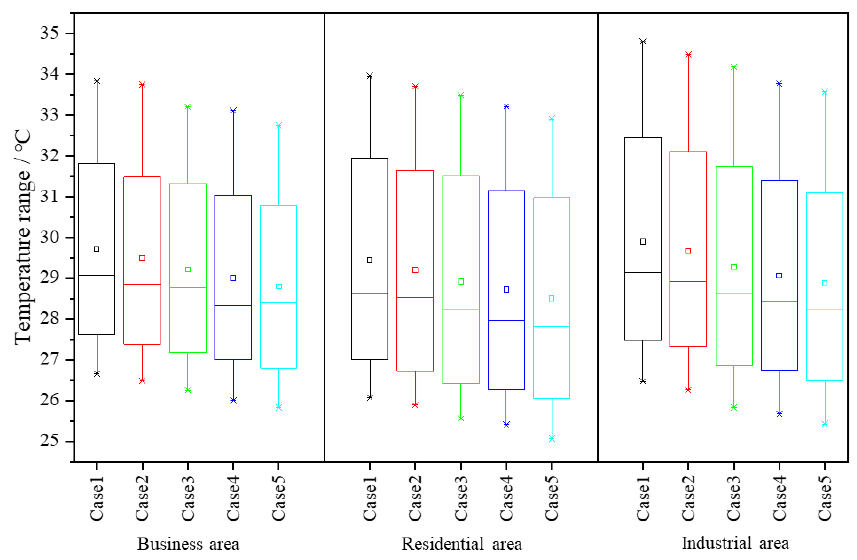
Figure 5. Daily temperature variation of five cases in the business, residential, and industrial areas.